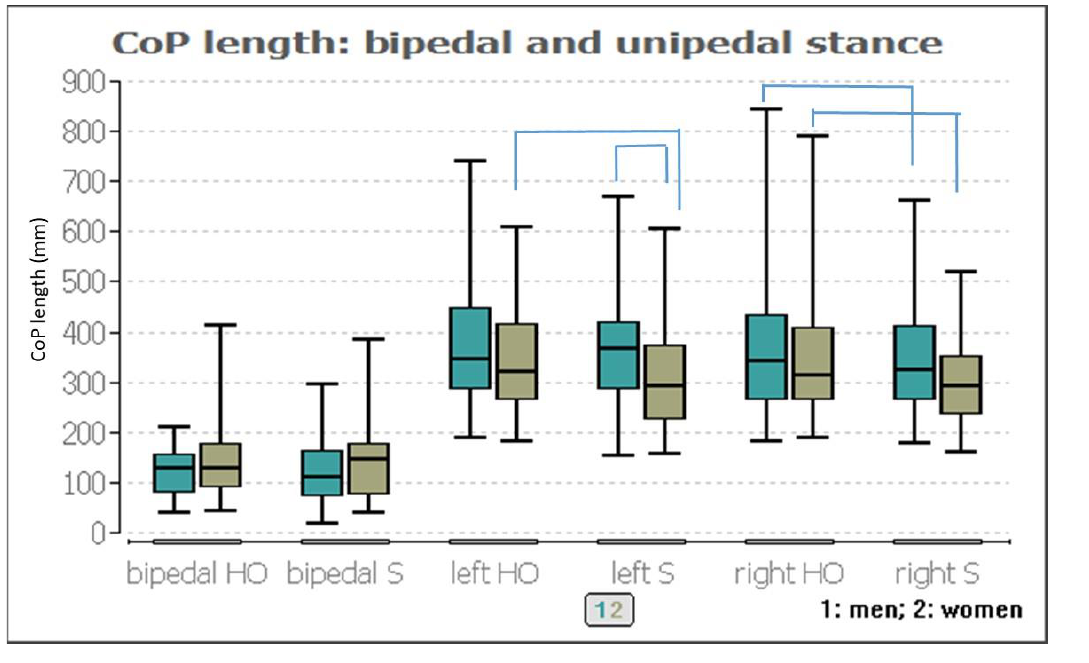
Figure 3. Center of pressure length with either habitual occlusion or splint, separated into male and female subjects.